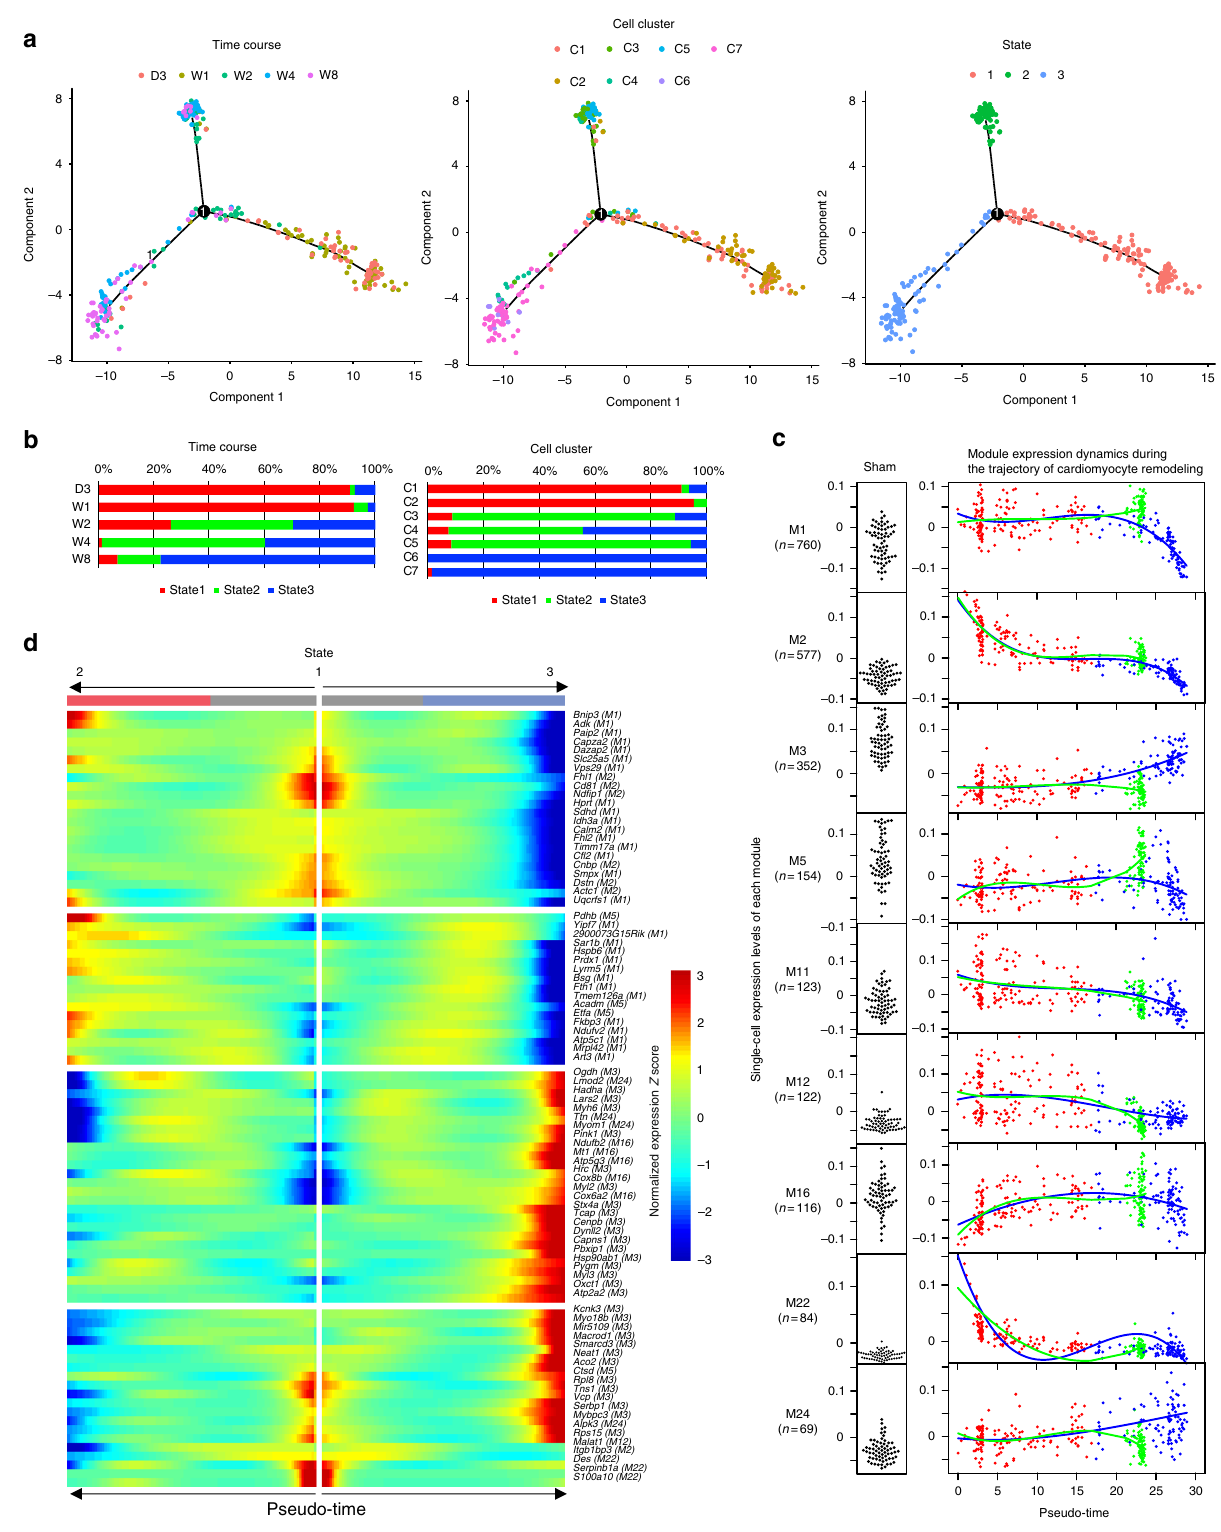
Fig. 2 Single-cardiomyocyte trajectory analysis. a Single-cardiomyocyte trajectory after TAC operation reconstructed by Monocle. Cells are colored by the time when cardiomyocytes were extracted (left), according to the cell clusters (middle), and by the cell states annotated by Monocle (right). b Bar plot showing the distribution of the cell states (State 1, State 2, and State 3) at each time point (left) and in each cell cluster (right). c Module expression dynamics along the pseudo-time reconstructed by Monocle. Dot colors indicate state colors, matching the colors in b . Single-cell expression levels of each module in sham cardiomyocytes are represented as black dots (left). The fi tted curves for the trajectory into State 2 (green) and State 3 (blue), and the number of genes assigned to the corresponding modules are also shown. d Heatmap showing the expression levels of differentially expressed genes during the trajectory. Corresponding modules are also denoted in